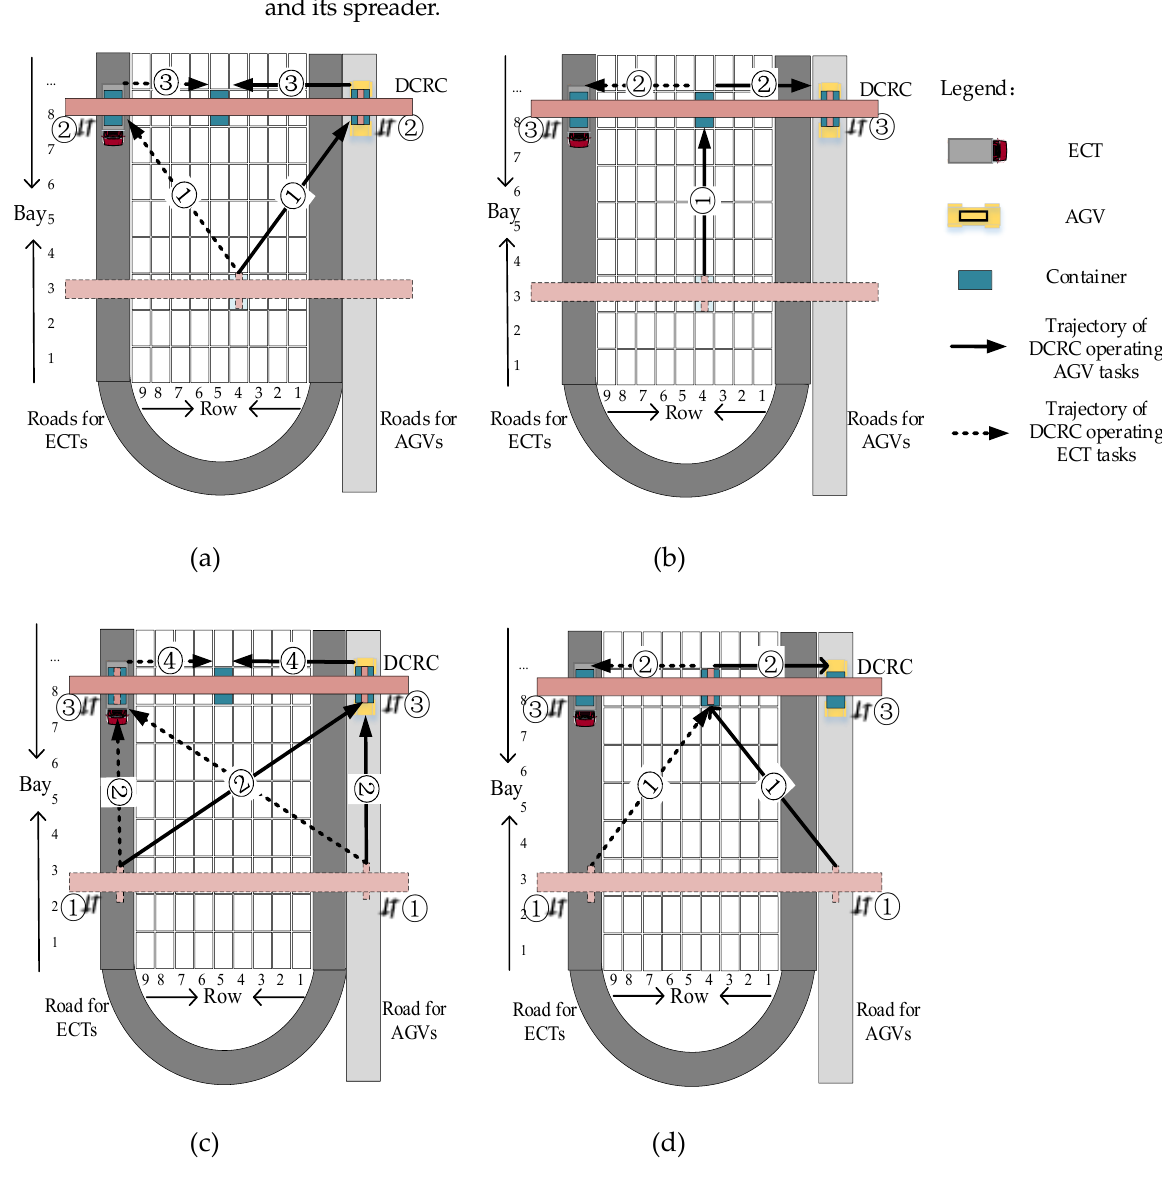
Figure 3. Operation process of the DCRC for handling different modes of tasks. ( a ) “PP” Mode; ( b ) “PT” Mode; ( c ) “TP” Mode; ( d ) “TT” Mode.